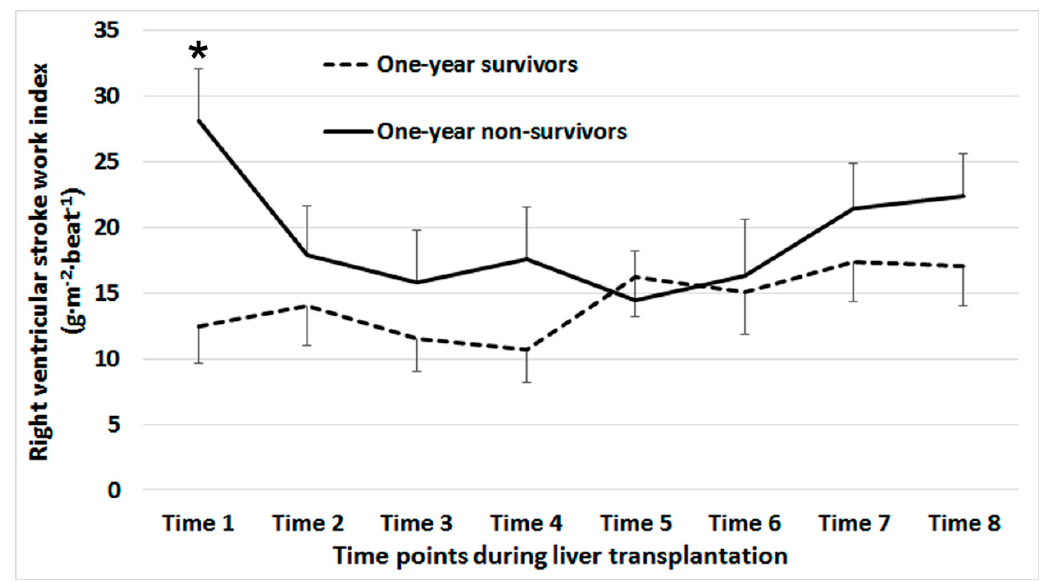
Figure 1. Time-dependent comparison of right ventricular stroke work index between one-year survivors and nonsurvivors. * Significant difference between groups ( p < 0.001). Time 1: after anesthesia induction; Time 2: 1 h after anesthesia induction, Time 3: 10 min after the beginning of the anhepatic phase, 5 min before (Time 4) and after (Time 5) graft reperfusion; Time 6: 20 min after reperfusion; Time 7: 5 min after the completion of biliary reconstruction; Time 8: at the end of surgery. Table 2. Multivariable Cox proportional hazard regression analysis to predict one-year all-cause mortality or graft failure after liver transplantation ( n =